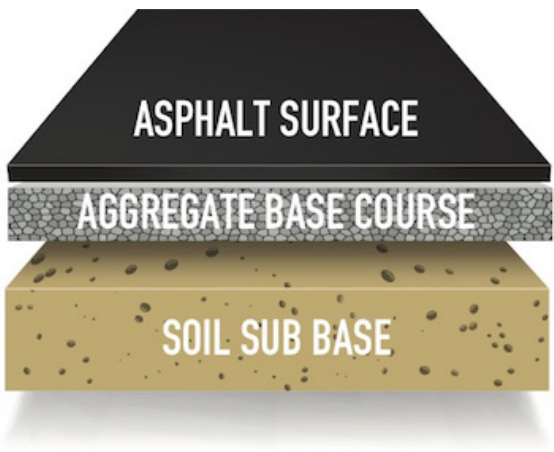
Figure 2. The layered structure of the underground